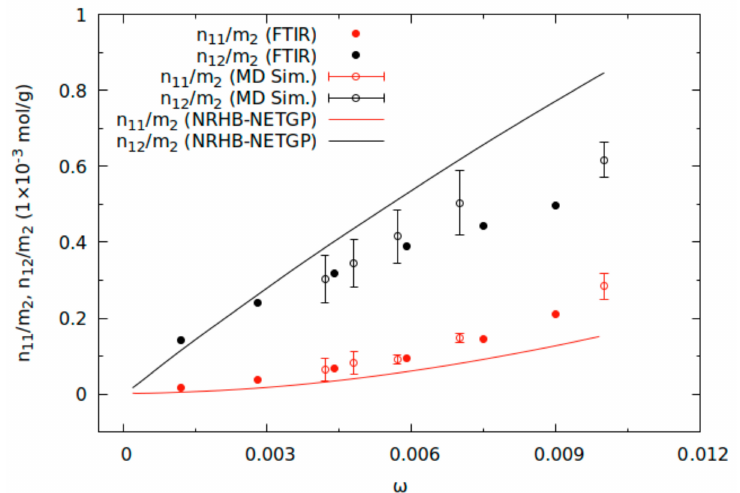
Figure 2. Comparison of the predictions of the NRHB-NETGP model for the amount of self and cross- HBs with the outcomes of FTIR spectroscopy and of MD simulations. Reprinted with permission from the authors of [10]. Copyright (2017) American Chemical